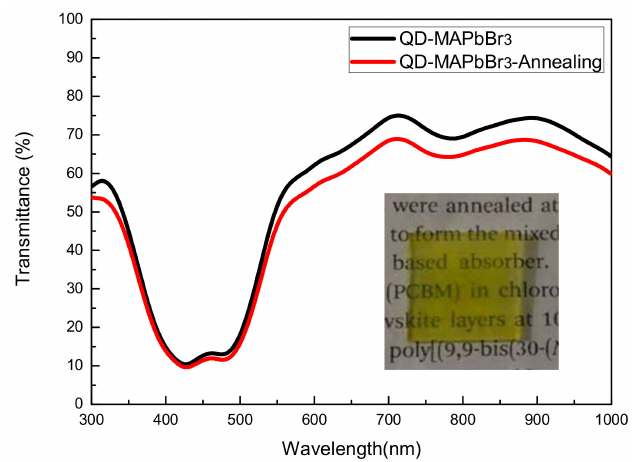
Figure 8. Transmittance spectra of the QD-MAPbBr 3 films with and without annealing treatment. The inset shows the picture of the QD-MAPbBr 3 film.